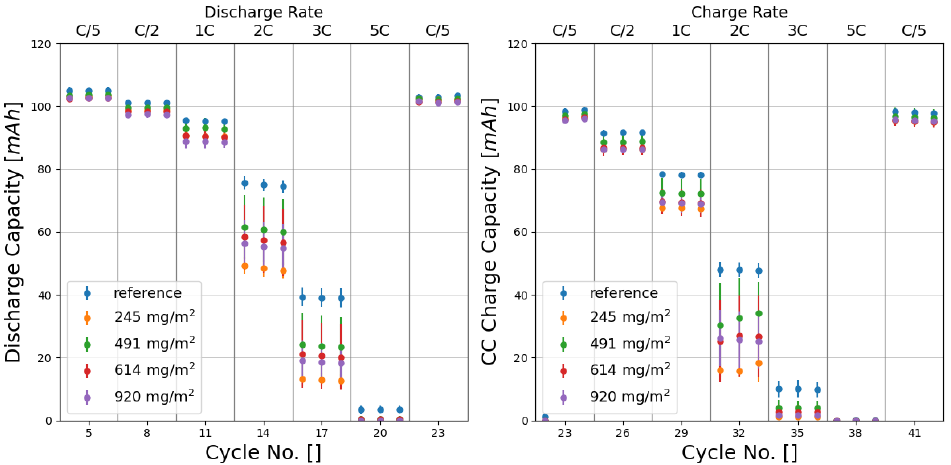
Figure 8. Results of C-rate tests on cells with PE separator. Varying polymer loading, laminated at harsh conditions of 100 °C and 12 N/mm; tests performed after formation.